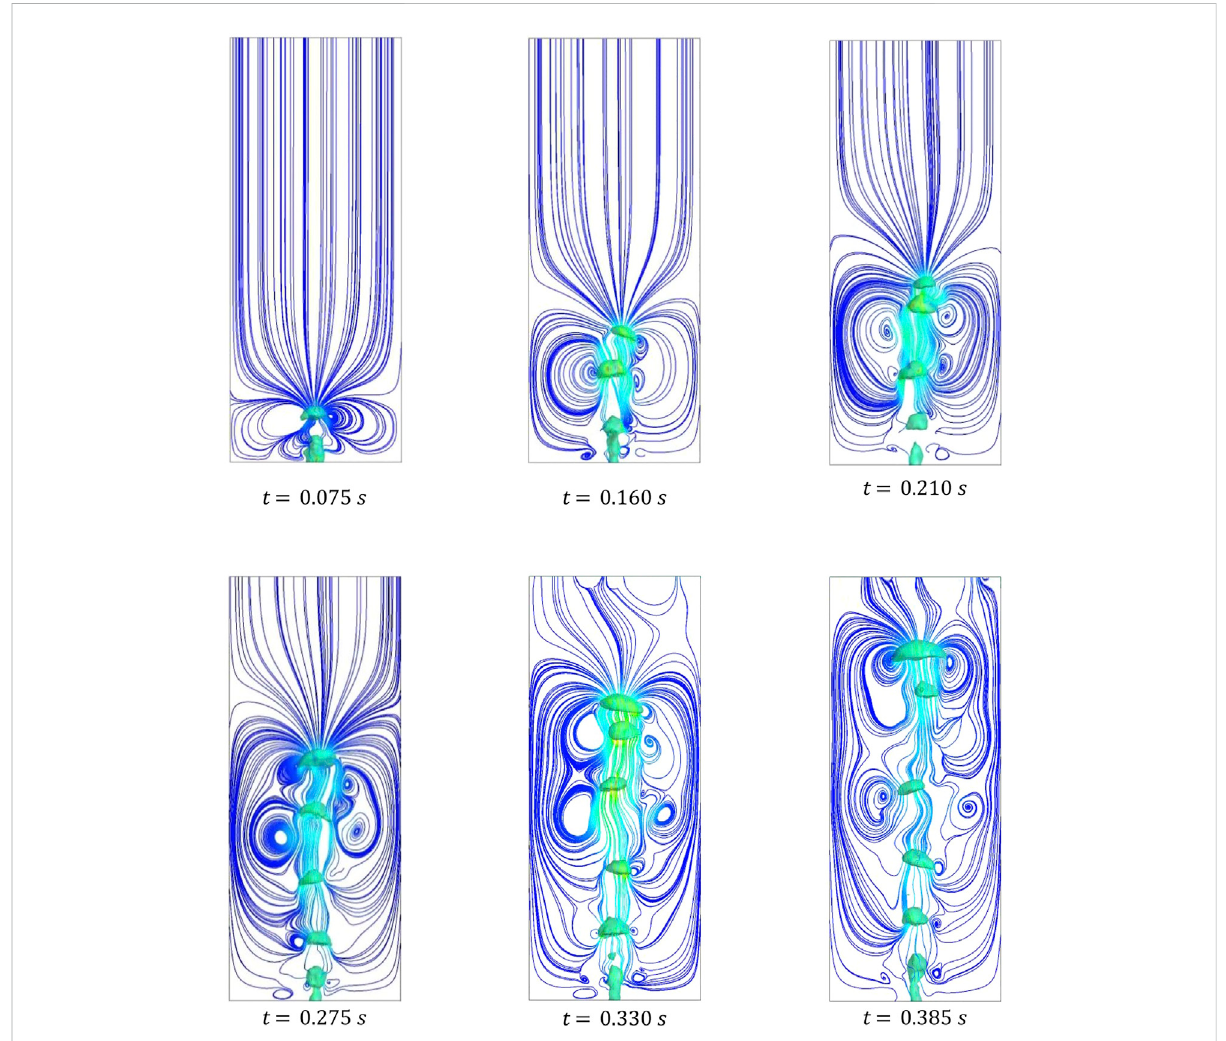
FIGURE 8 Streamlines of the velocity fi eld of bubbles released by gas injection in molten LBE, v g (cid:1) 1 m / s